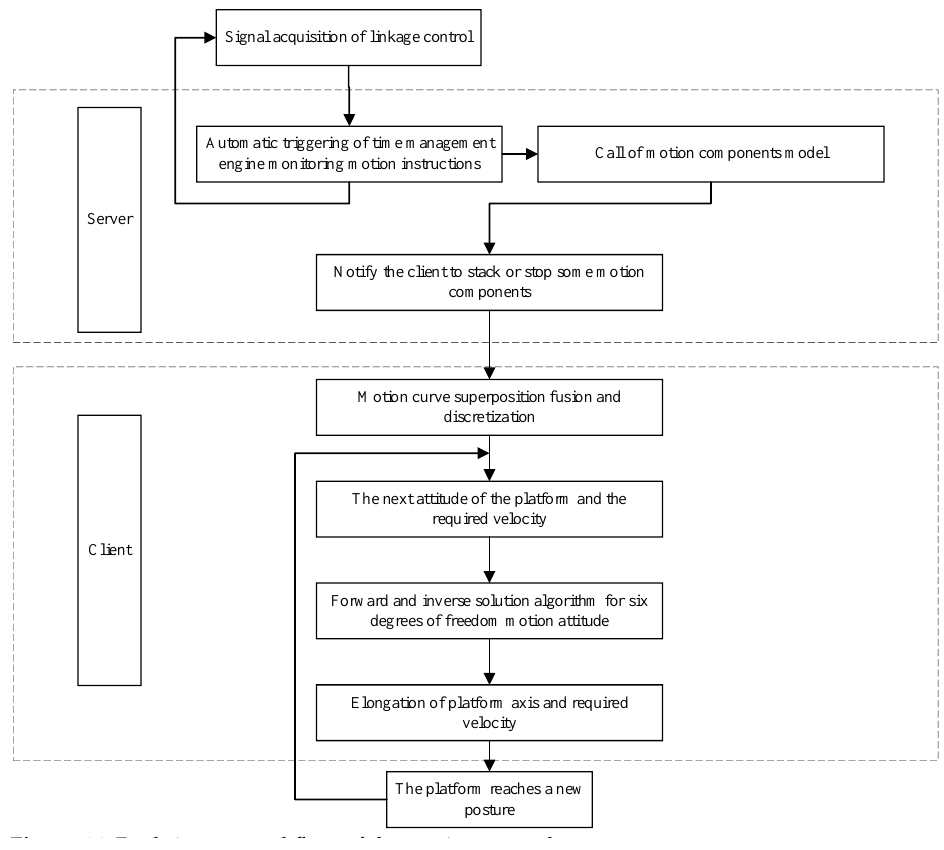
Figure 14. Real-time control flow of the motion control system.